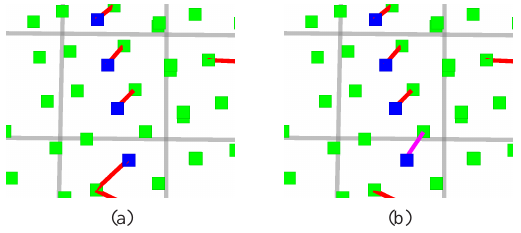
Figure 6: Assigning point correspondences. (a) For every point of a 3D scan (blue), a corresponding map point (green) is initially assigned from the cell’s point list (red line). (b) If the distance to neighboring cells is smaller than the distance to the initial as- signment, closer points might be found in the neighboring cell (magenta